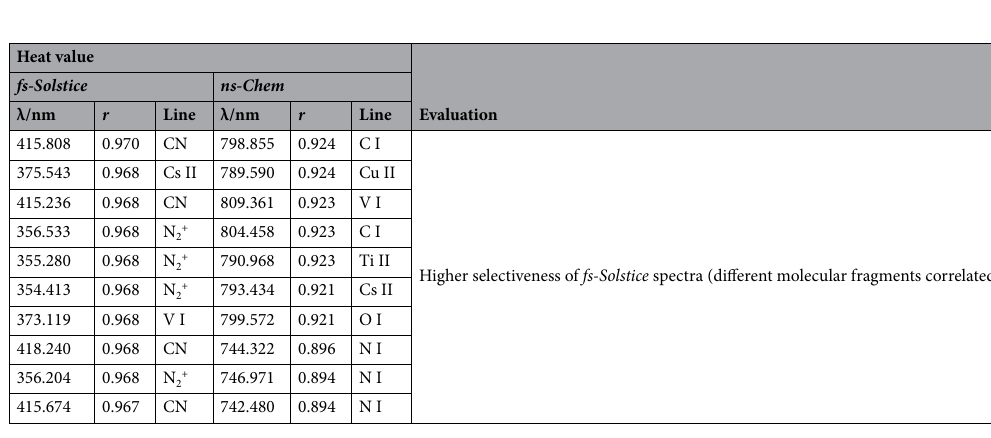
Table 2. Evaluation of fs-Solstice spectra correlation to heat value in coal